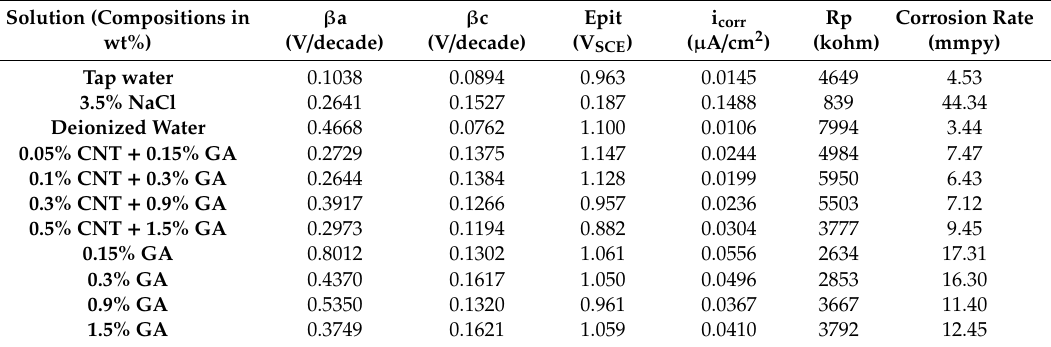
Table 5. Corrosion parameters for 316L stainless steel tested in di ff erent solutions at room temperature. Solution (Compositions in